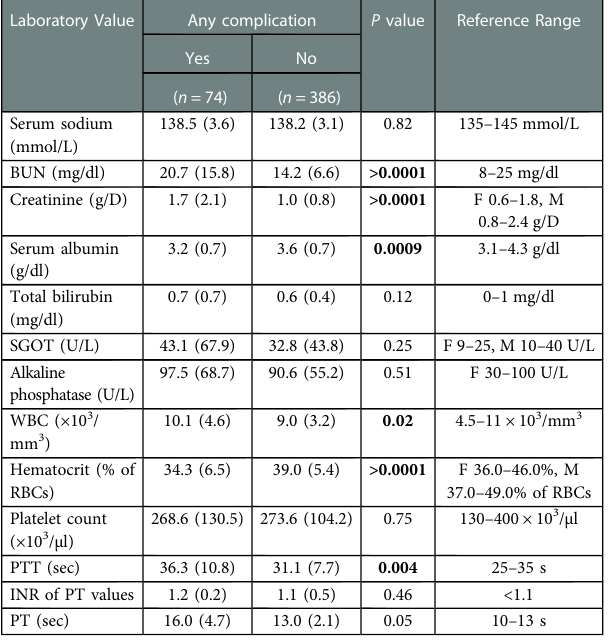
TABLE 6 Preoperative laboratory values (reported as mean values with standard deviation) and their association with the occurrence of any